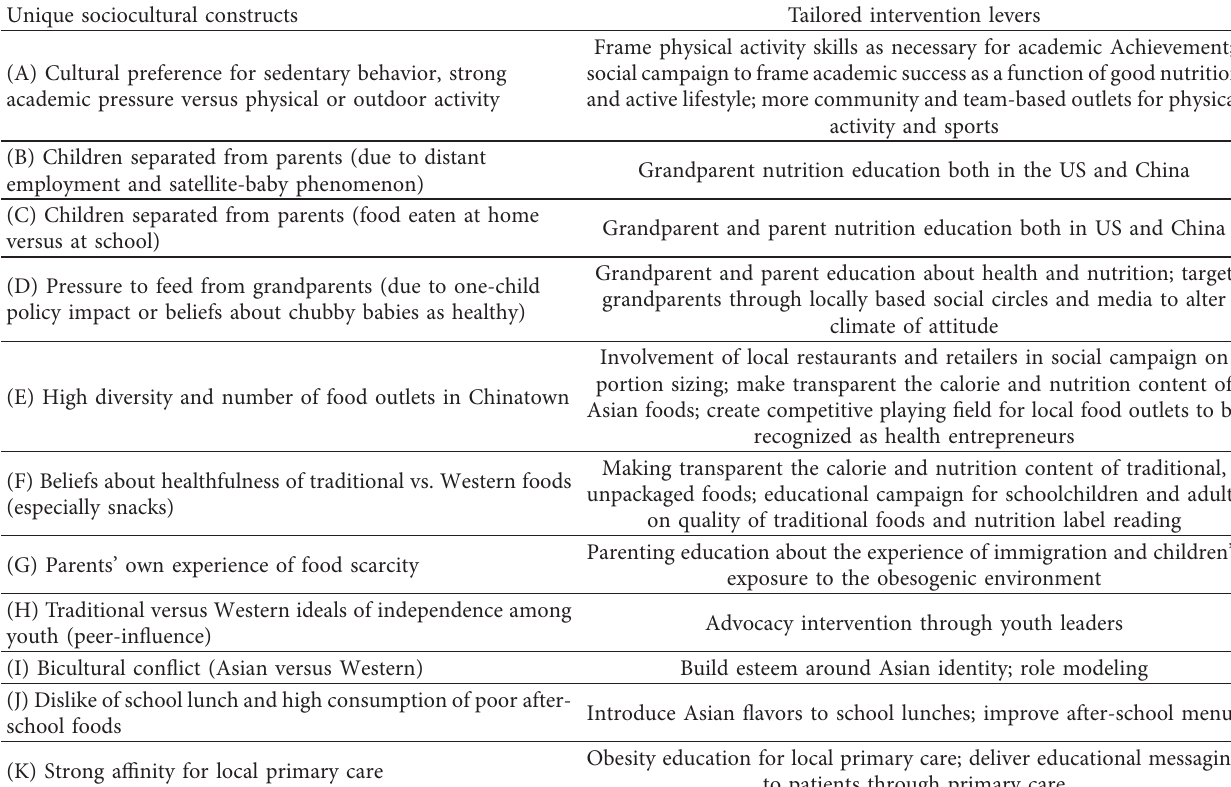
Table 2: Unique sociocultural constructs and tailored intervention